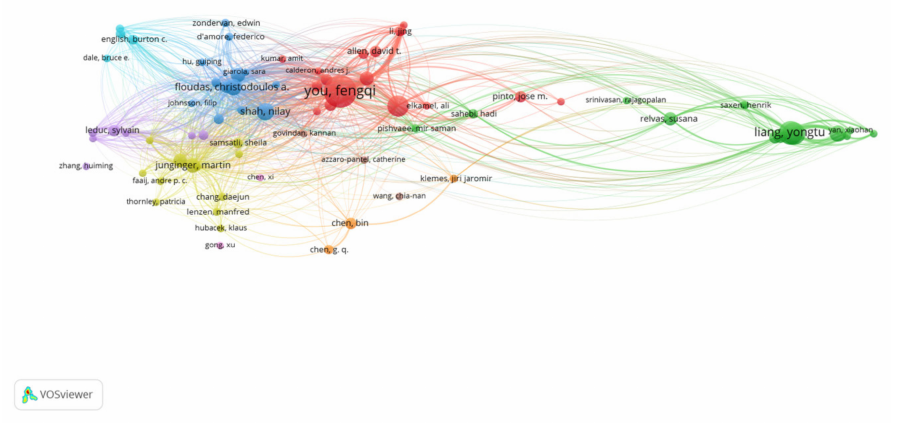
Figure 7. Bibliographic coupling map of the authors.